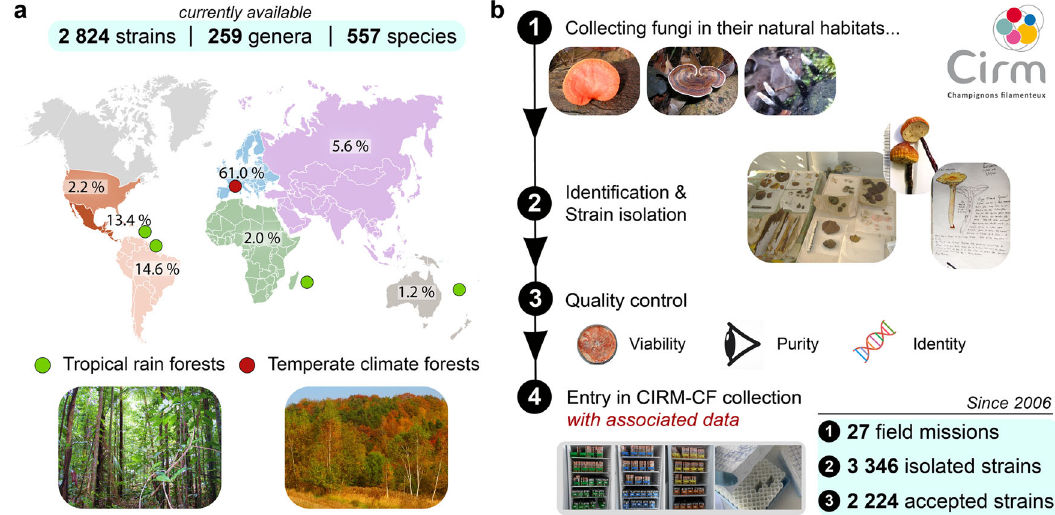
Fig. 1 Diversity and enrichment strategy of the CIRM-CF fungal collection. a Overview of the taxonomic and geographic diversity of the 2824 (as of May, 2021) available fungal strains preserved in the CIRM-CF. b Work fl ow of strains enrichment in the CIRM-CF collection from 2006 to 2020, with fungi coming from mainly France and its overseas territories. The fi rst step consists in collecting fungi in their natural habitat. Second, each collected sample is registered and identi fi ed by expert mycologists. The strain isolations are directly performed in a fi eld laboratory, by the CIRM-CF or by associated mycologists from Universities and French learned societies. Finally, the viability, the purity, and the identity of each strain are checked. When the strains are viable, pure, and when the molecular information is in accordance with the morphological identi fi cation, the strains can enter the CIRM-CF